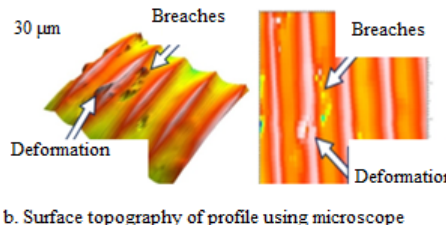
Figure 6. ( a ) Machined faces micrographs and ( b ) surface topography of the profile.